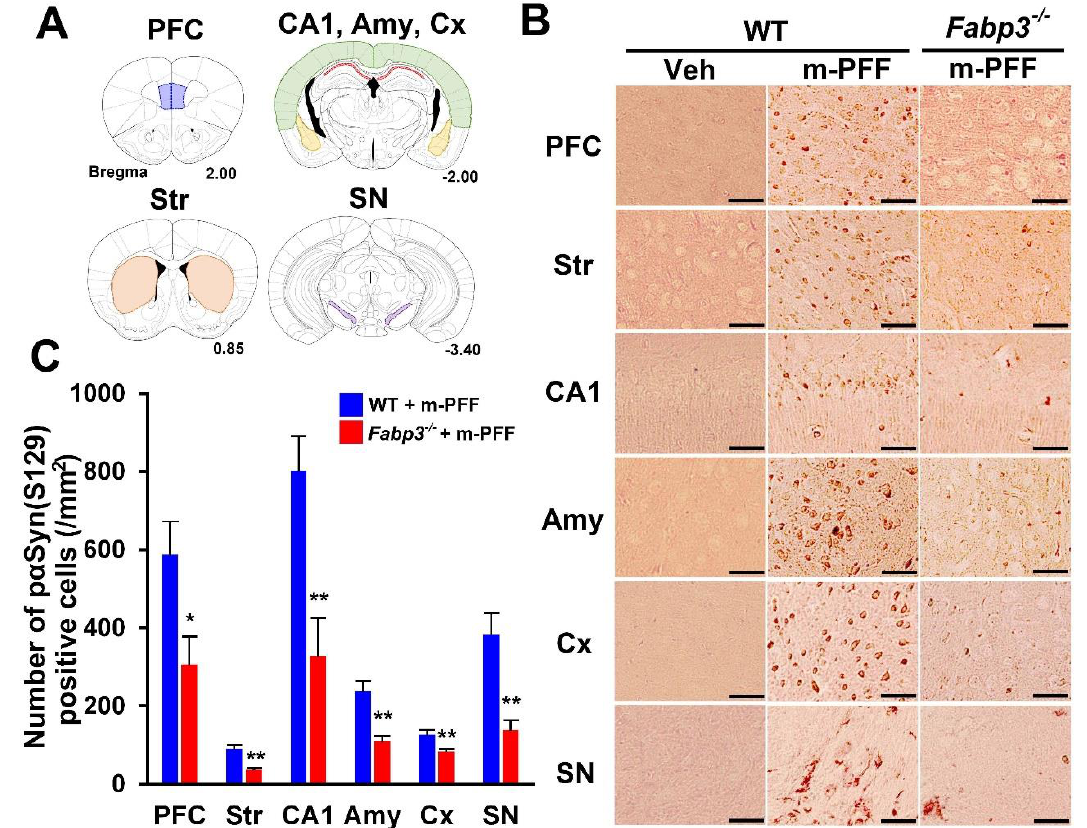
Figure 3. Immunostaining of phosphorylated α -Syn in mouse α -Syn PFF-injected WT and Fabp3 − / − mice. ( A ) Analyzed brain areas are shown in blue (PFC), orange (striatum), red (hippocampal CA1 region), yellow (amygdala), green (cortex), and purple (SN). ( B ) Representative images of phosphorylated α -Syn immunostaining treated with proteinase K (37 ◦ C for 30 min) in brain slices from WT and Fabp3 − / − mice injected with mouse α -Syn PFF. Scale bars: 120 µ m. ( C ) A reduced number of phosphorylated α -Syn positive cells was observed in Fabp3 − / − mice compared to WT mice following mouse α -Syn PFF injection ( n = 6 per group). Error bars represent SEM. * p < 0.05, ** p < 0.01 vs. WT mice. Amy: amygdala, CA1: cornu ammonis 1, Cx: cortex, KO: Fabp3 − / − mice, PFC: prefrontal cortex, m-PFF: mouse α -Syn PFF injection, SN, substantia nigra, Str: striatum, Veh: vehicle injection, WT: wild-type mice.